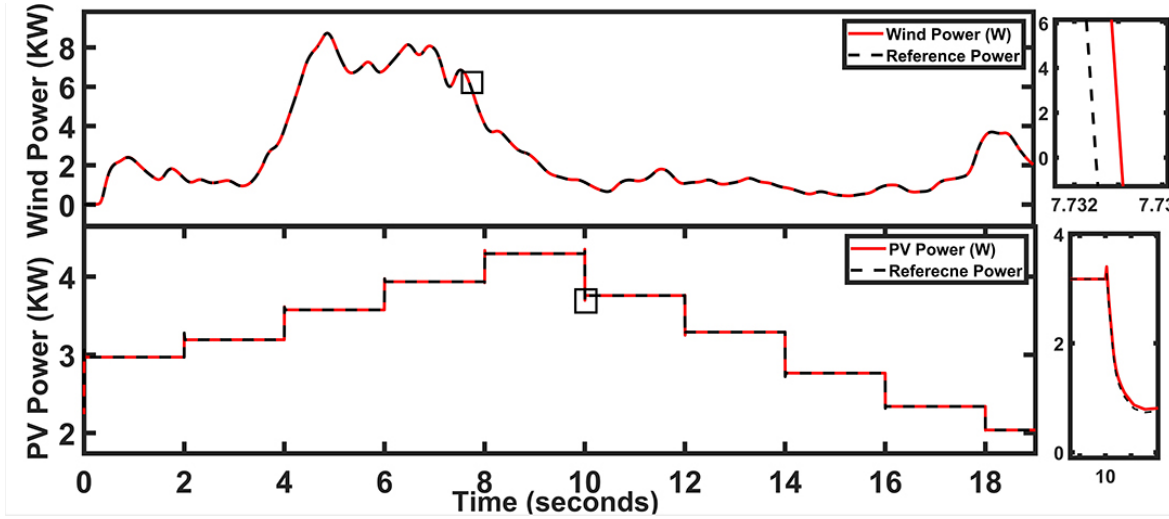
Figure 11. Power generated by wind and PV